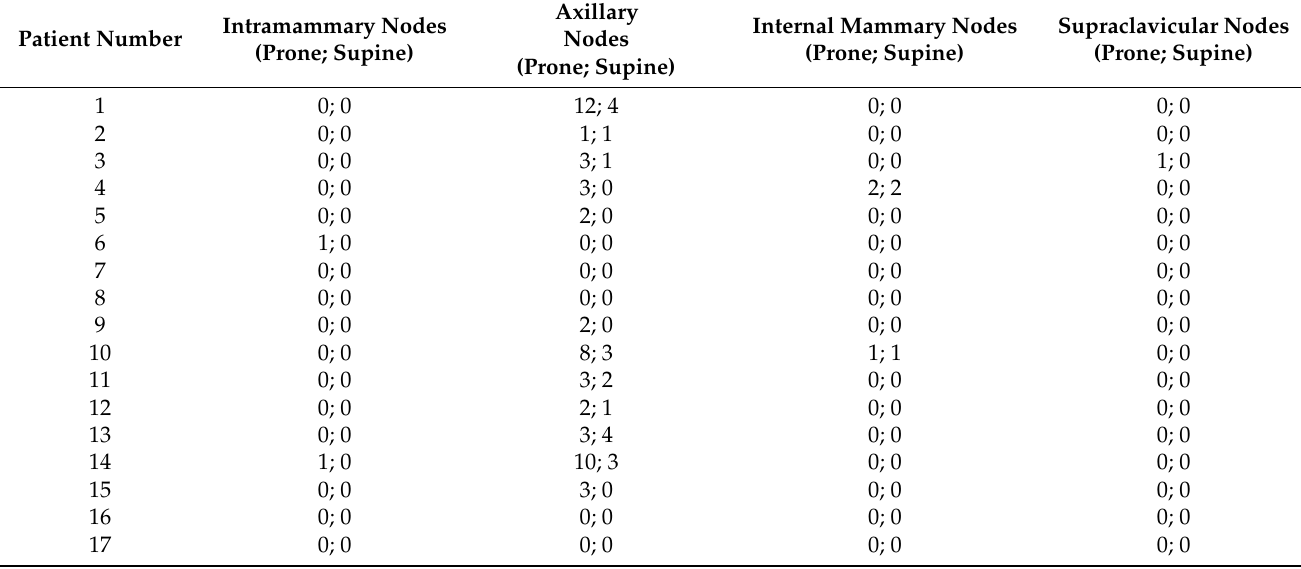
Figure 3. MIP ( a , d ) showing FDG avid lesions in the right breast with axillary lymph node metastasis. Fused axial PET/CT images in supine ( b ) showing a lesion (white arrow) in the right breast, which is better delineated on prone ( c ) with the visualization of an additional lesion (red arrow). Fused coronal PET/CT cuts of supine ( e ) and prone ( f ) acquisition are displayed. Table 2. Lymph nodes detected on prone versus supine